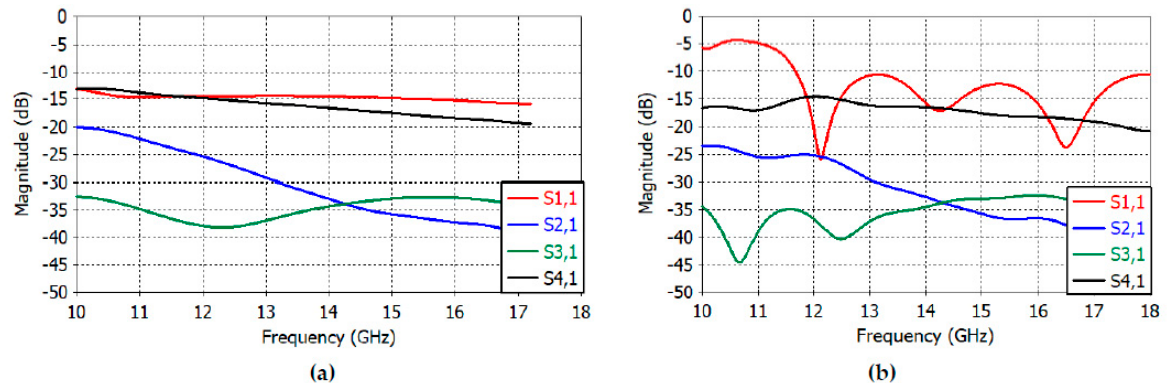
Figure 3. ( a ) Reflection and transmission coefficients of the TE 10 -mode-excited rectangular feed. ( b ) Reflection and transmission coefficients of the probe-excited rectangular feed.